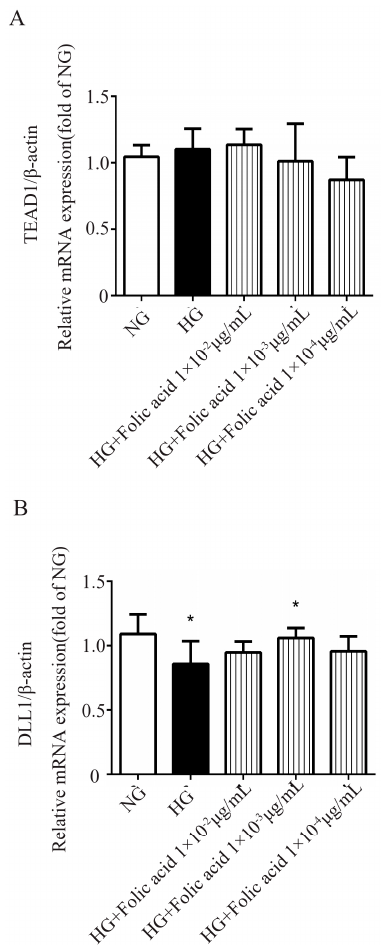
Figure 4. Folic acid decreased the TEAD1 mRNA and increased the DLL1 mRNA level in the RVECs. The cells were treated with 1 × 10 − 2 μ g/mL, 1 × 10 − 3 μ g/mL, 1 × 10 − 4 μ g/mL of folic acid for 72 h. The mRNA levels of TEAD1 ( A ) and DLL1 ( B ) were assessed by Real-Time PCR. The data was presented as means ± SD ( n = 4). * p < 0.05, compared with HG-treated